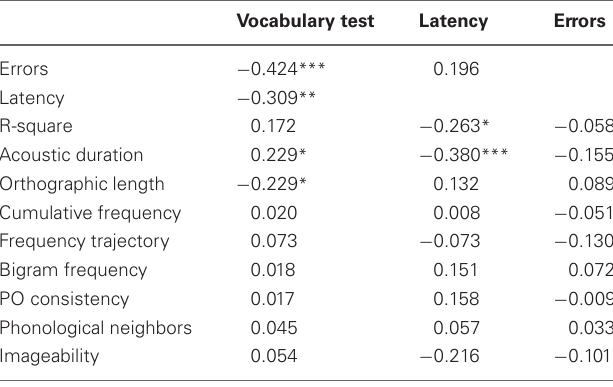
Table 5 | Correlations between the by subject independent variables’ effects (rows) and vocabulary test scores, mean latencies, numbers of errors and correct